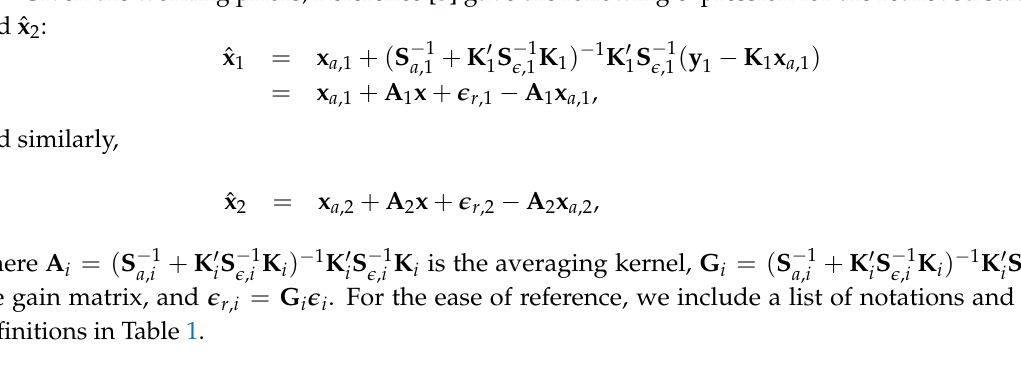
Table 1. Reference guide for the mathematical